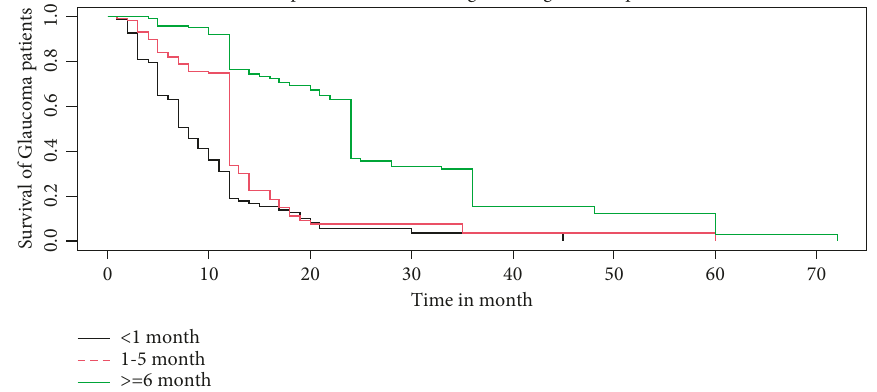
Figure 2: KM plot of duration of diagnosis of glaucoma patients. Table 3: Formal statistical test of glaucoma patients’ survival patterns at Jimma University Specialized Hospital from 2016 to 2020 ( n �